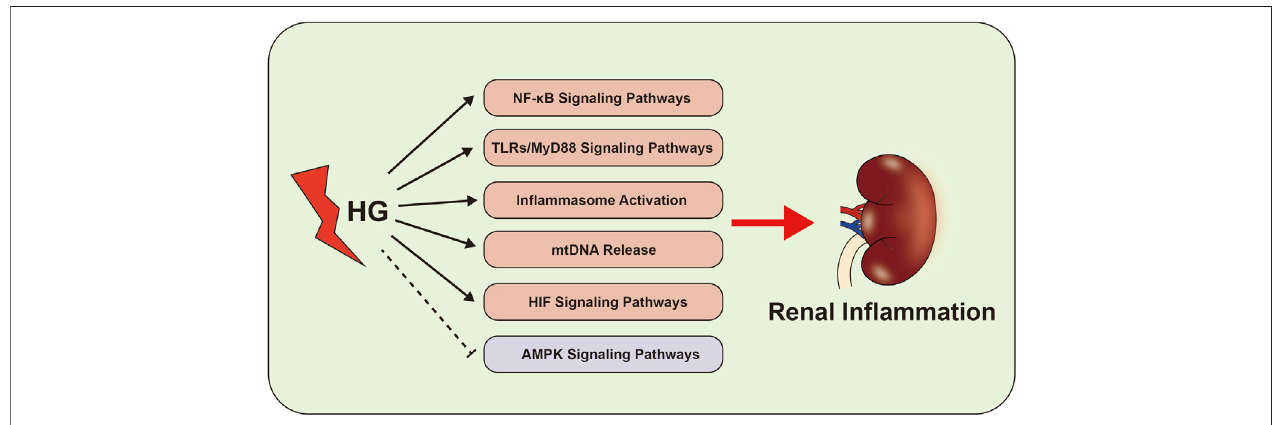
FIGURE 2 | In fl ammation-related signaling pathways in the development of DKD. The abnormal of NF- κ B signaling pathways, TLRs-MyD88 signaling pathways, in fl ammasome activation, AMPK signaling pathways, mtDNA and HIF signaling pathway activate the renal in fl ammation, which cause to kidney damage in DKD.